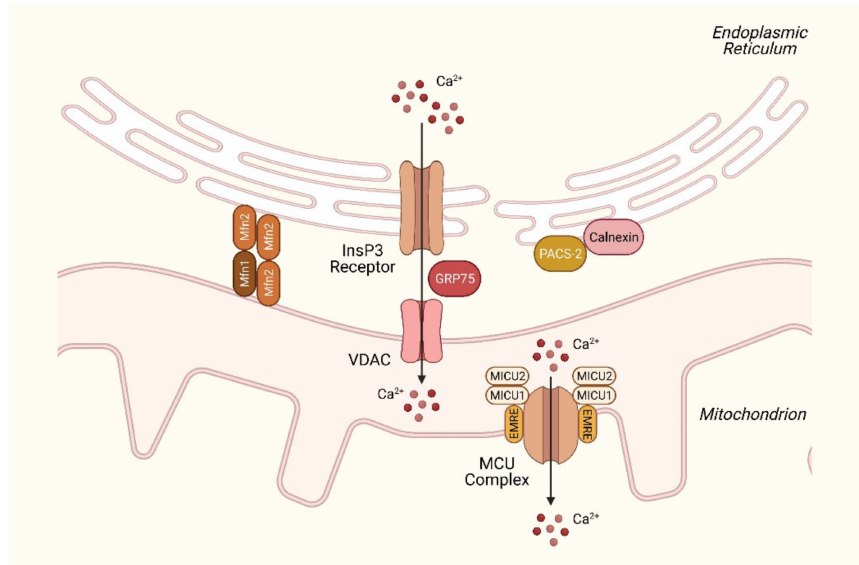
Figure 2. Schematic representation of Ca 2+ flux at the ER–mitochondria contact sites. The ER and mitochondria are functionally coupled through physical interactions at contact sites (also known as MAMs), allowing Ca 2+ transport from the ER to mitochondria through the InsP3 receptor and VDAC. The two ion channels are connected by the chaperone GRP75. The MAM structure is stabilized by tethering proteins Mfn1/2 and interactions between calnexin and PACS-2. Ca 2+ enters the mitochondrial matrix via the MCU complex at the inner mitochondrial membrane. MCU-binding proteins MICU1/2 control the opening of the channel, while EMRE assists the MCU–MICU interaction and regulates the complex activity. Abbreviations: InsP3, inositol-1,4,5-trisphosphate; Mfn1/2, mitofusin 1/2; VDAC, voltage-dependent anion channel; MCU, mitochondrial Ca 2+ uniporter; MICU1/2, mitochondrial Ca 2+ uptake 1/2; EMRE, essential MCU